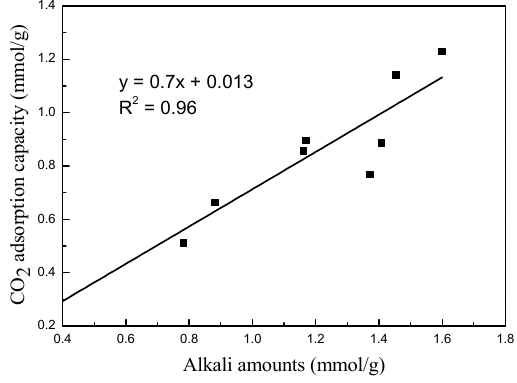
Figure 8. Relationship between CO 2 adsorption capacity and effective alkali amounts.